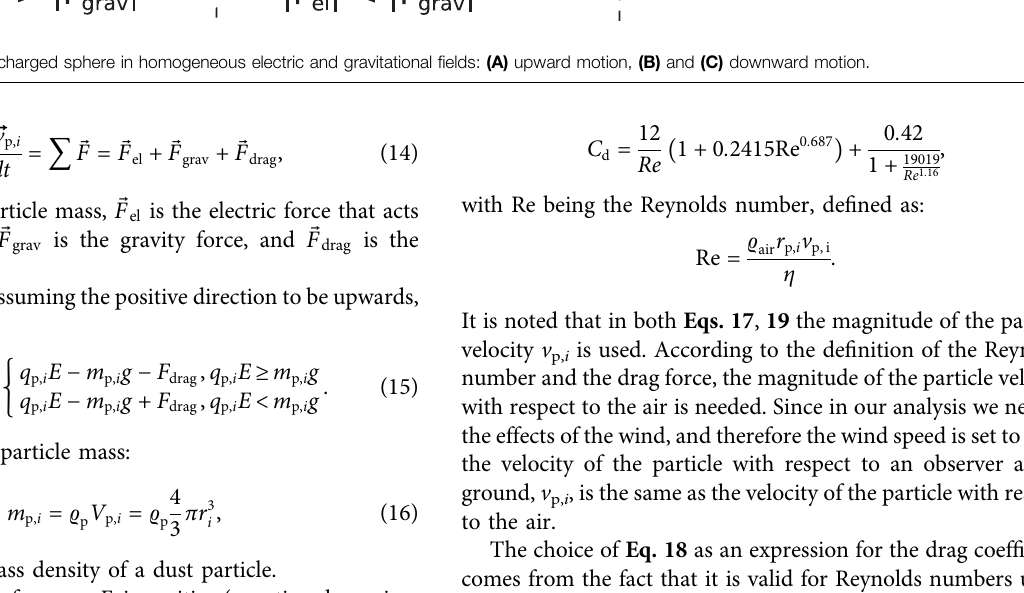
Frontiers in Earth Science |